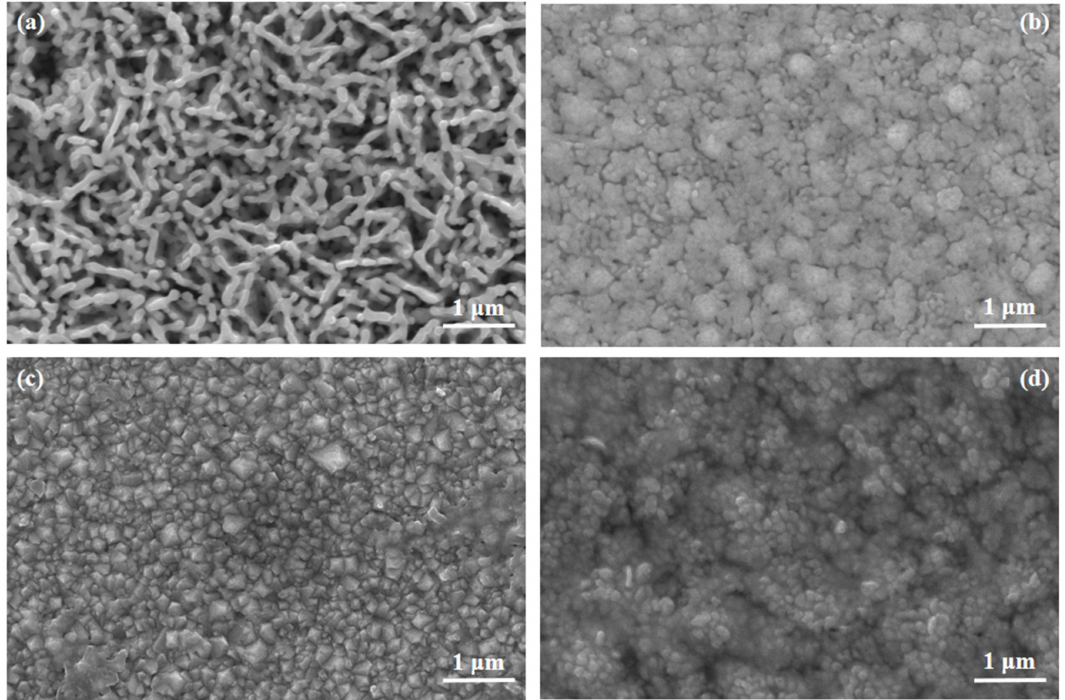
Figure 2. FESEM top-view micrographs of ( a ) Mo-BiVO 4 , ( b ) Mo-BiVO 4 /C photoanodes, and ( c ) Cu 2 O and ( d ) Cu 2 O/C